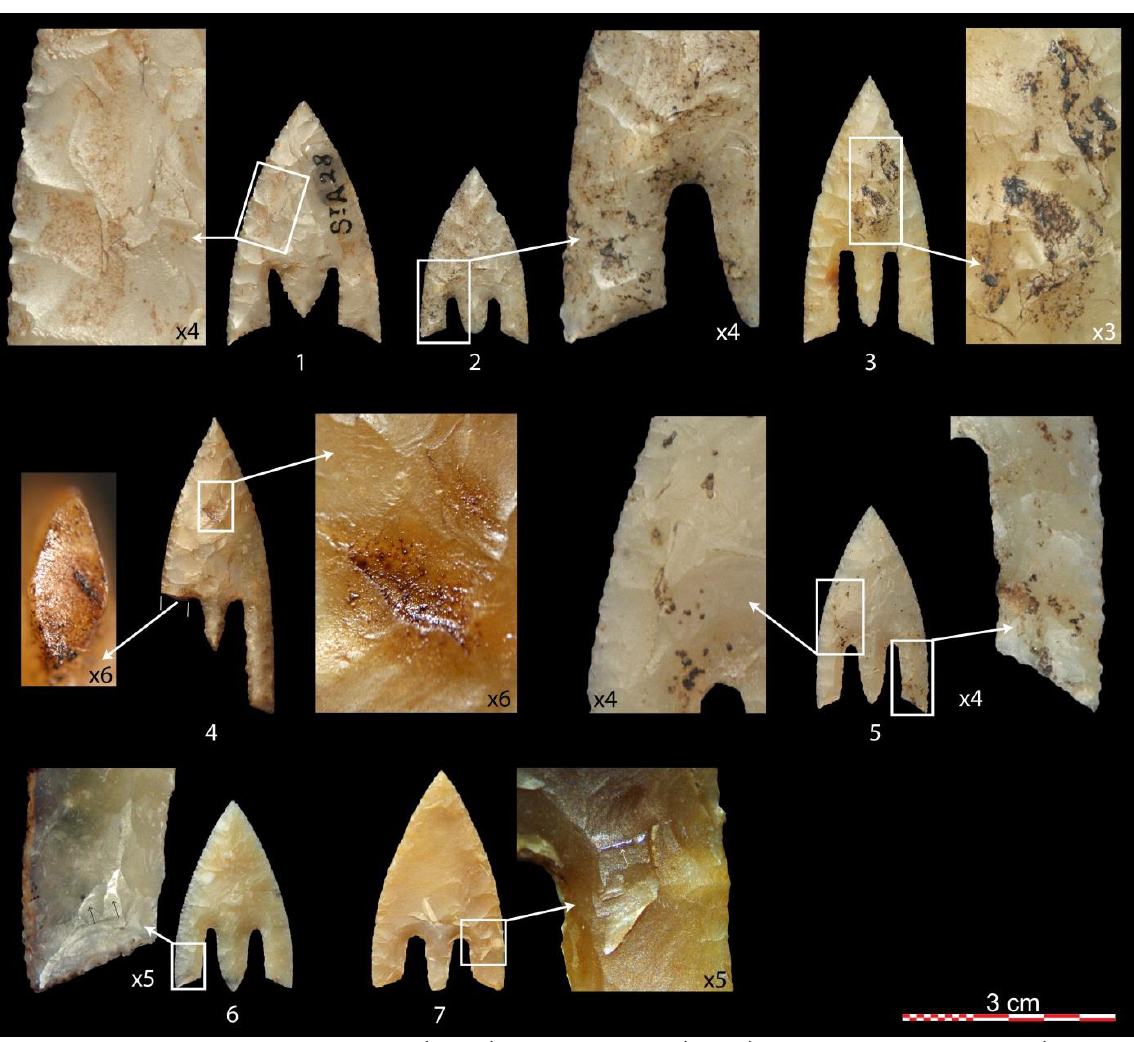
Figure 12. Macroscopic remains of glue (1 to 5) and bright spots (6 & 7) on Armorican arrowheads (photo C. Nicolas). 1. arrowhead from Brun-Bras barrow, Saint-Adrien, Côtes-d'Armor; 2. arrowhead from Rumédon barrow, Ploumiliau, Côtes-d'Armor; 3. arrowhead from Tossen-Rugouec barrow, Prat, Côtes-d'Armor; 4. arrowhead from Graeoc 2 barrow, Saint-Vougay, Finistère; 5 & 6. arrowheads from Kernonen barrow, Plouvorn, Finistère; 7. arrowhead from Crec’h-Perros barrow, Perros-Guirec,